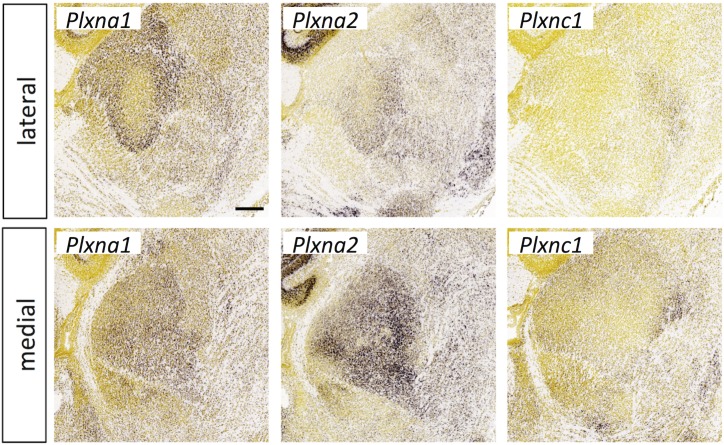
Plexin expression in the thalamus at E18.5.In situ hybridization data from sagittal sections of the thalamus at E18.5 obtained from the devABA revealed differential patterns of expression of plexins (Plxn) PlxnA1, PlxnA2 and PlxnC1. See text for details. Two representative and equivalent sections are shown for each plexin, one lateral and the other medial (see S8 Fig for details on how the sections were selected). Scale bar in PlxnA1: 248 μm.